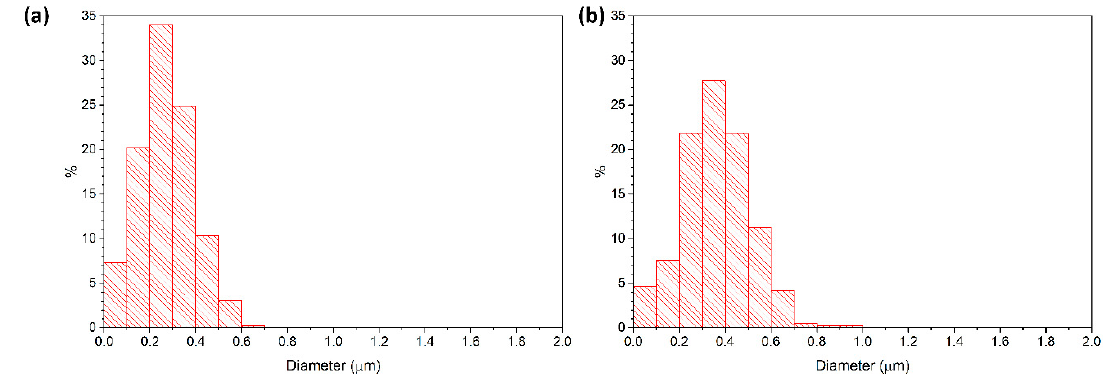
Figure 11. Grain size distributions of ( a ) a two-step sintered sample (T1 = 1400 °C, T2 = 1350 °C, t2 = 5 h) and ( b ) a conventionally sintered sample. Both samples prepared from ball milled powder.